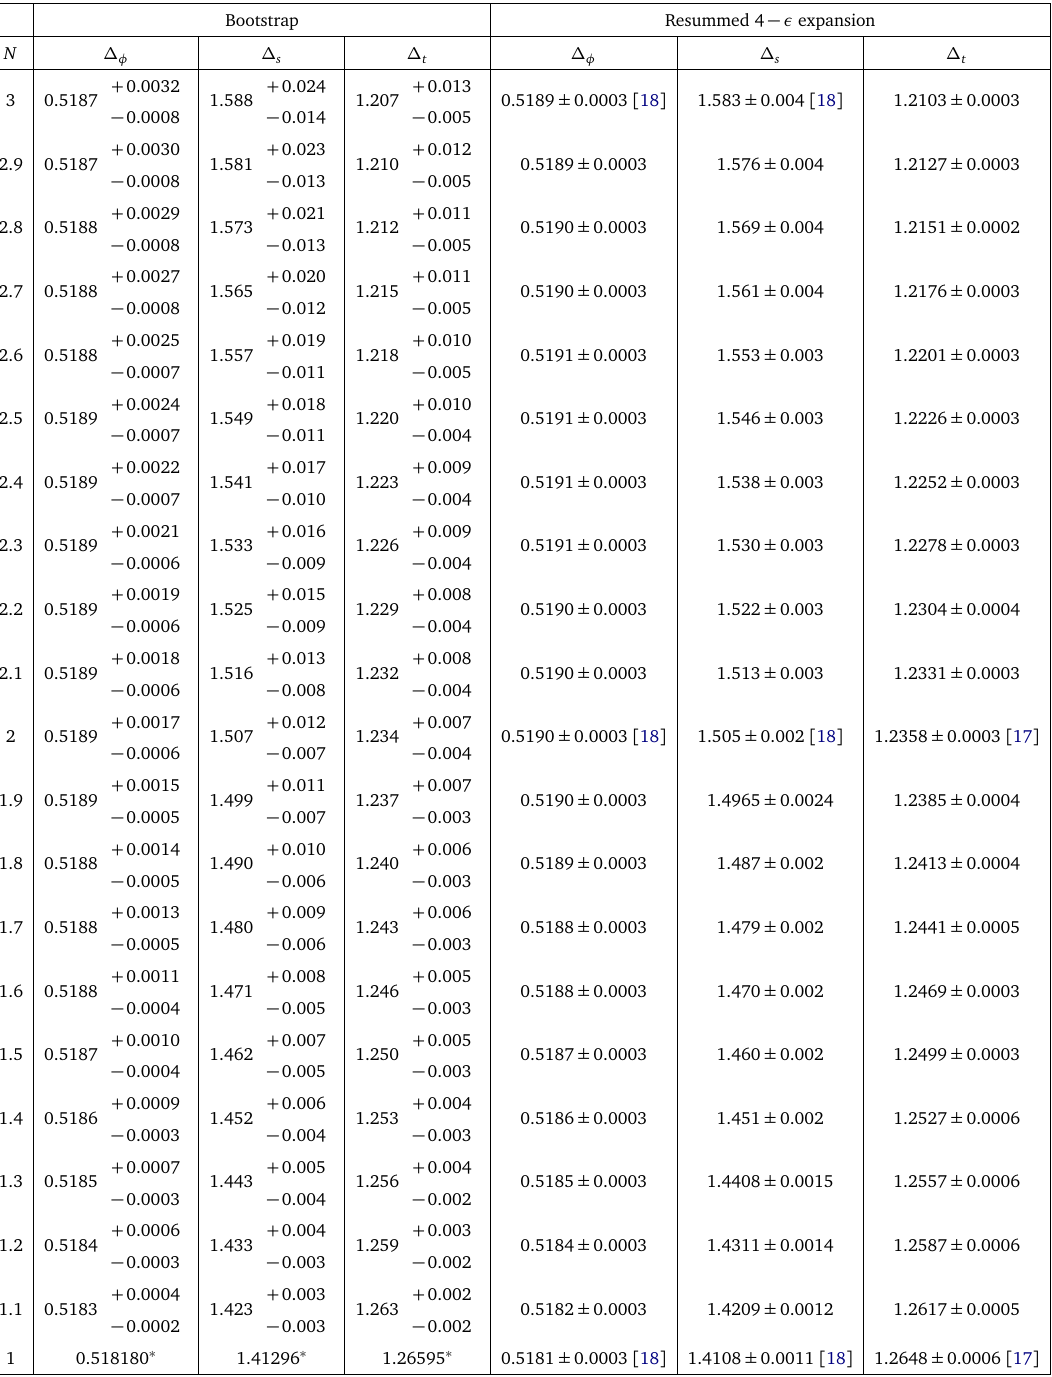
Table 2: Same as table 1, for the scaling dimensions instead of the anomalous di- mensions, for d = 3 and N ∈ [ 1,3 ] . Bootstrap results are given as the values at the transformed navigator minimum, with uncertainties given by the distance to the maximal and minimal values determined by the Constrained BFGS algorithm (the values at the navigator minimum are given with asterisks in cases where uncertain- ties were not calculated). Cited values are taken from Fig. 2 of [ 17 ] or deduced from the ancillary file “resummation.pdf” of [ 18 ]